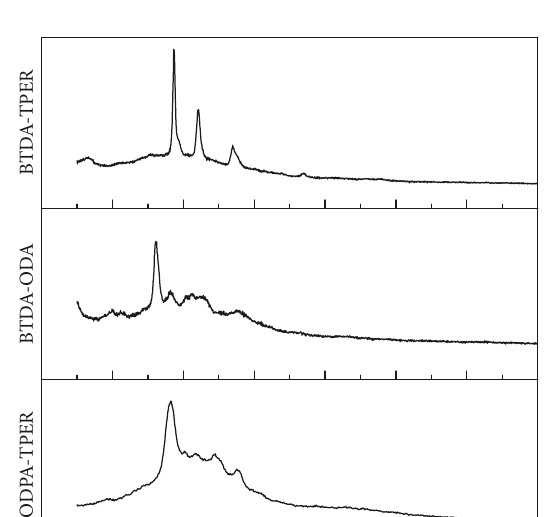
Figure 3: Melting curves of PI.